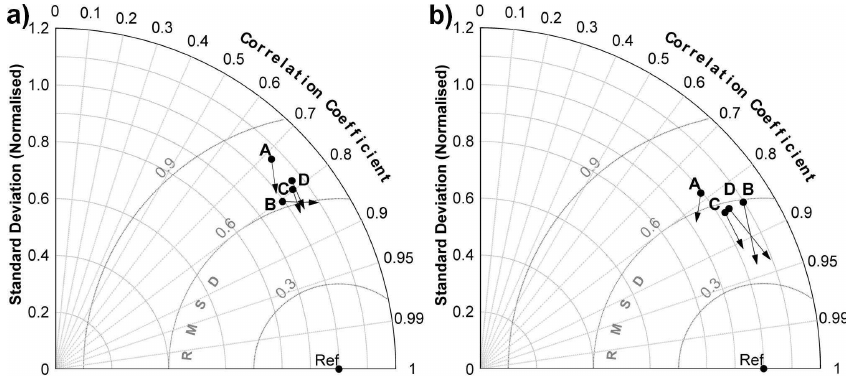
Fig. 5. Taylor diagrams of the validation results for the groups listed in Table 3. RMSD and standard deviation are normalised against the reference represented by the time series of the corresponding FLUXNET station; therefore, the point denoted as “Ref” represents the location in the diagram of the time series of every station. (a) shows the results of the comparison between daily time series of modelled E and the E measured at the 43 FLUXNET stations. The dots correspond to the statistics of the model run with the satellite R n as input; the arrows point the results of the model validation when using the R n measured at the stations as input. (b) shows how the statistics improve when comparing monthly averages instead of daily time series (using the station R n as input).